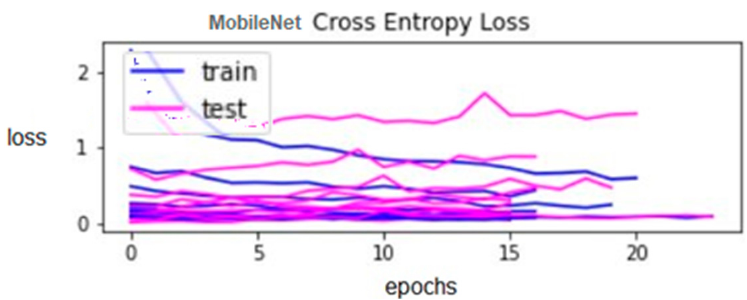
Figure 3. MobileNet Cross entropy loss.